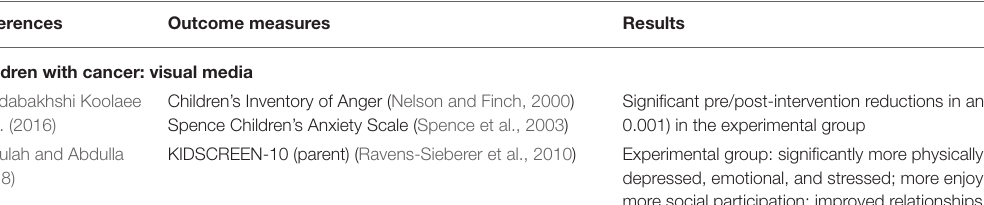
TABLE 4 | Outcome measures and